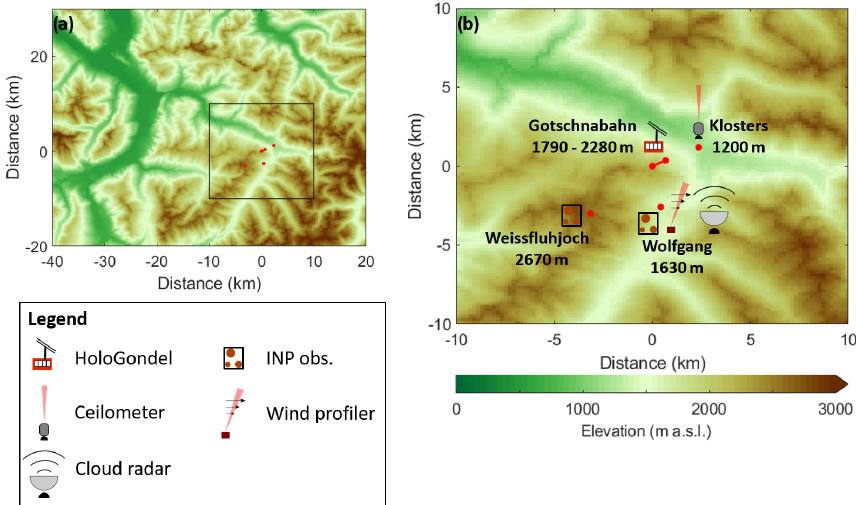
Figure 1. Overview of the measurement location and the experimental setup. The geographical location of the Gotschnabahn and the surrounding topography is shown in (a) . An enlarged section of the measurement sites (black rectangle in a ) and the instrument setup are shown in (b) . The elevation data were taken from the digital height model DHM25 of the Federal Office of Topography swisstopo: https://shop.swisstopo.admin.ch/de/products/height_models/dhm25200 (last access: 9 March